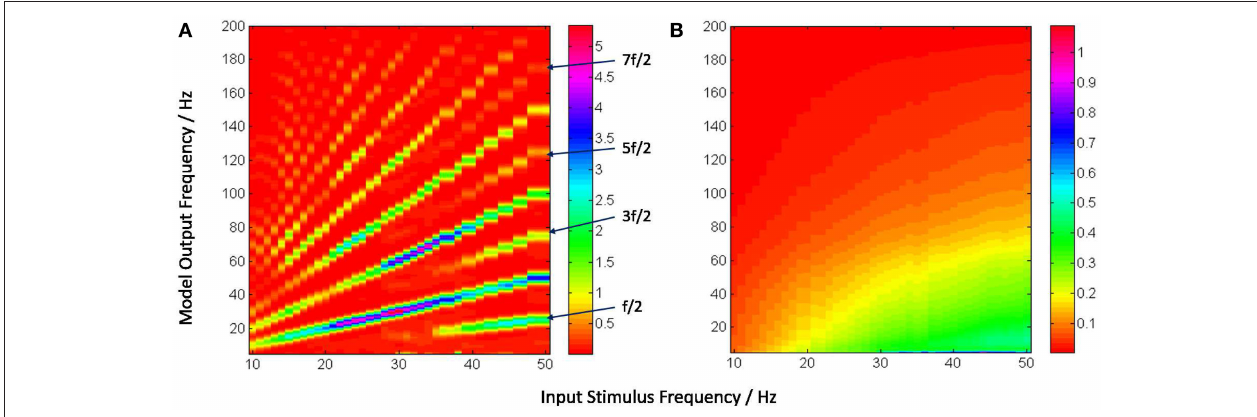
FIGURE 6 | The model output power spectra (y-axis) corresponding to (A) periodic and (B) Poisson spike-train inputs in the range 10–50 Hz at a resolution of 1 Hz (x-axis), and spanning the upper-alpha (10–13 Hz), beta (14–30 Hz) and gamma ( > 30 Hz) EEG frequency bands. The figures correspond to the case when the IN feed-forward inhibition is suppressed in the circuit and the TRN feedback inhibition is dominant. The power spectra in (A) show distinct subharmonic contents for frequencies > 40 Hz, and are indicated by